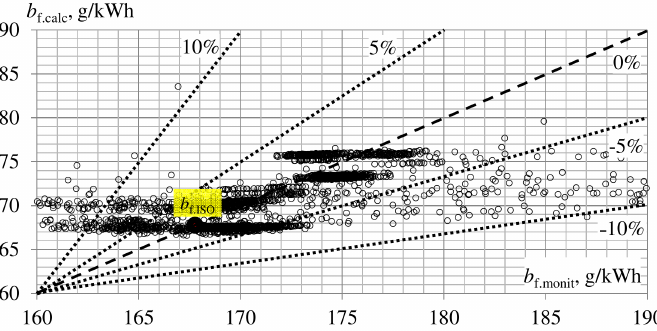
Figure 8. Mass specific fuel consumption calculated values b f.calc against monitoring data b f.monit .